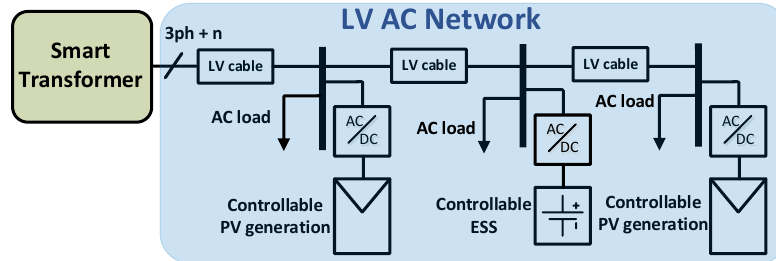
Figure 10. Computational model for the LV AC